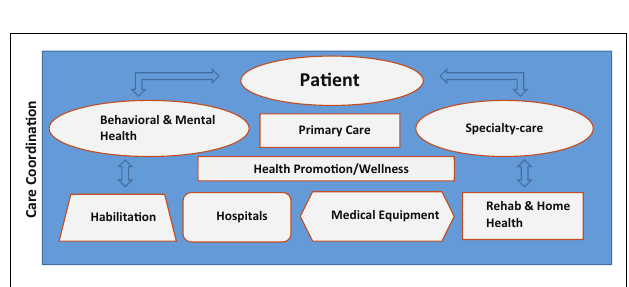
FIGURE 4 | Integration of care